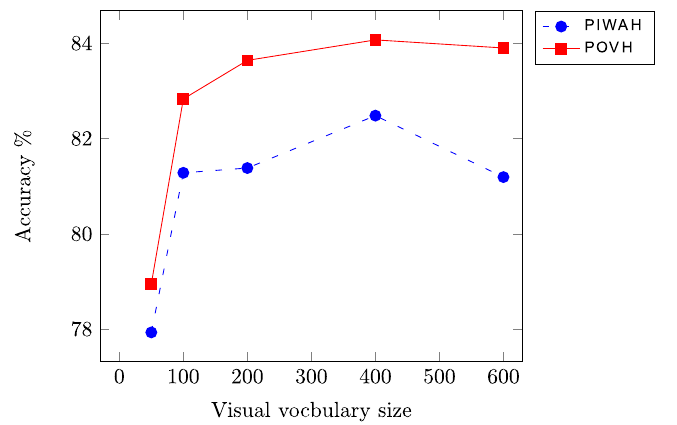
Fig 10. Comparison of classification accuracy with the research based on spatial approaches for RSSCN